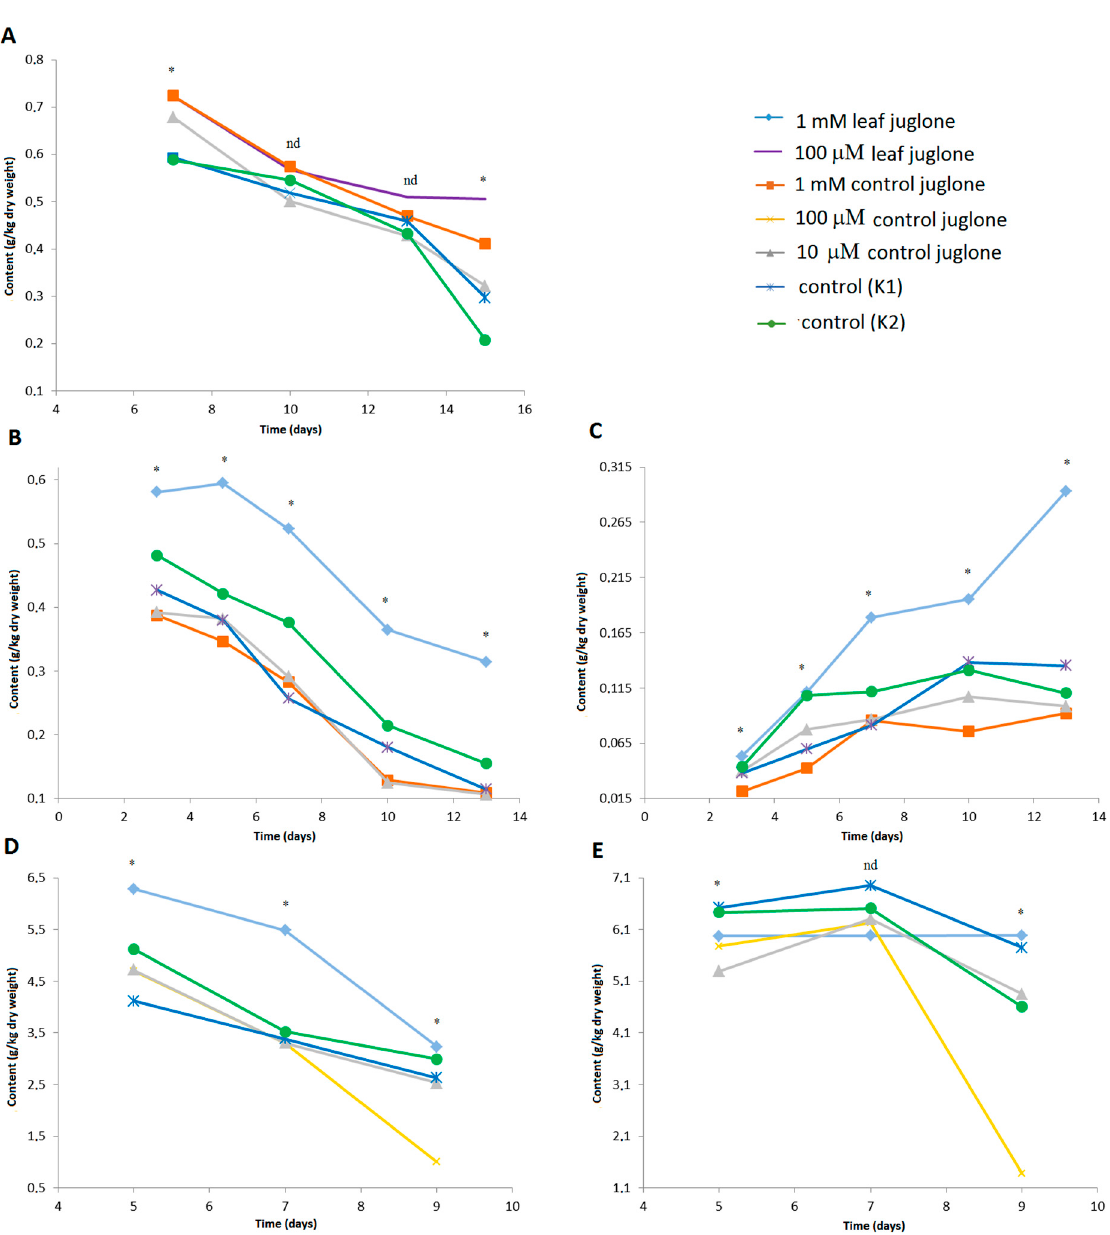
Figure 5. Effects of control juglone and known leaf extract juglone treatments on content of selected individual phenolic compounds identified, as caffeoyl hexaric acid 2 in S. Lycopersicum ( A ), kaempferol trirhamnoside dihexoside 1 ( B ) and kaempferol glycoside acylated 2 ( C ) in L. culinaris , and 3.5-dicaffeoylquinic acid ( D ) and caffeoyltartaric acid hexoside ( E ) in L. sativa . K1, extraction medium (vehicle); K2, water; *; are significantly different ( p < 0.05); nd, not significantly different.